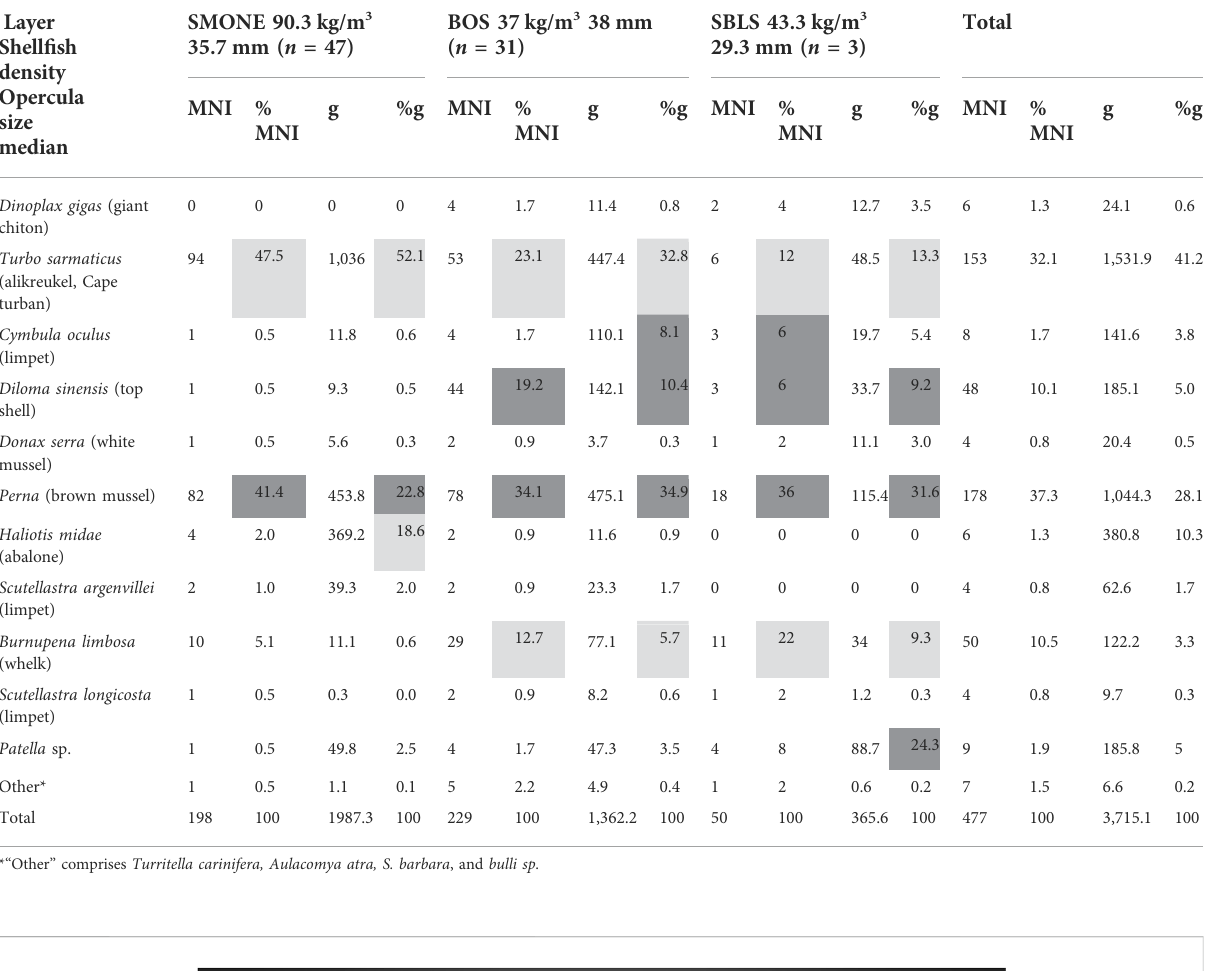
TABLE 3 Shell fi sh MNI and weight; shell fi sh density and opercula size (median); and layers SMONE, BOS, and SBLS. The ecopro fi le for the top > 85% taxa is indicated through light gray shading (sheltered conditions) and dark gray shading (exposed wave interaction conditions). The taxa are ordered according to rank in terms of handling costs (Langejans et al. 2012).